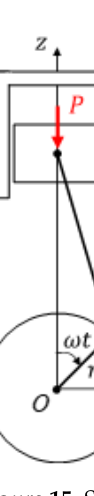
Figure 15. Schematic diagram of an engine crank mechanism.